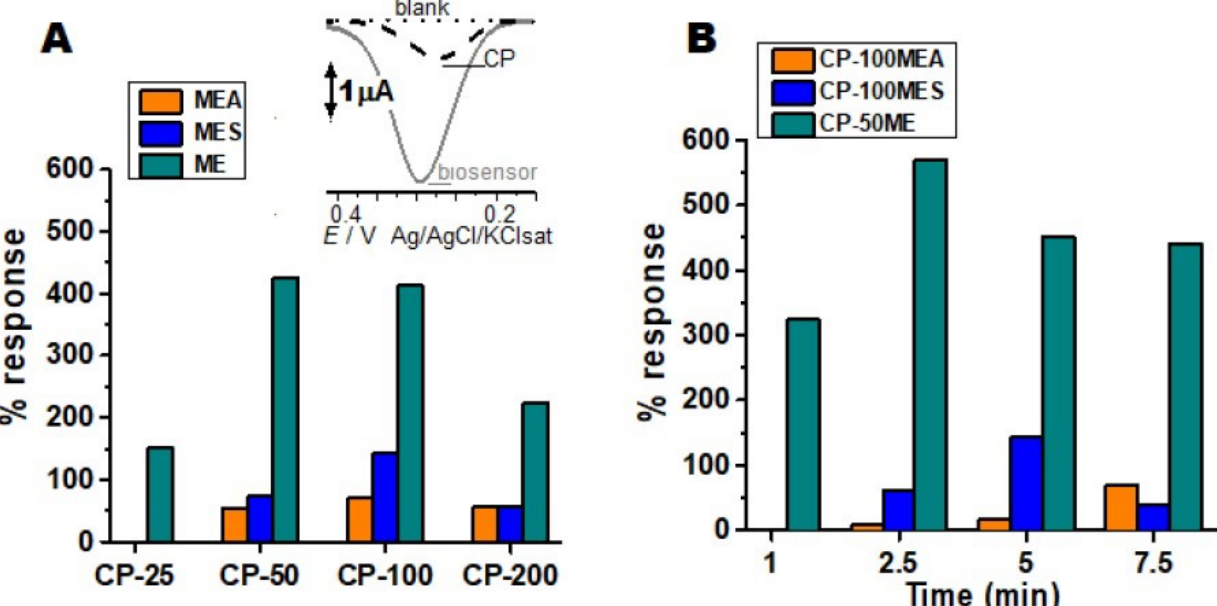
Figure 1. Optimization of biosensors with crude enzymatic extracts. Control: Non modified carbon paste ( A ) enzymatic extracts obtained from solid medium (MEA), minimal liquid medium (ME), and complex liquid medium (MES) in different proportions (25, 50, 100 or 200 µ L in 70 mg of graphite) in the construction of biosensors, tested with the catechol substrate at 10 µ M. Inset: CP-50ME and bare CP in the analysis of the catechol 10 µ M. ( B ) Different enzyme reaction times of the biosensors in the 10 µ M catechol solution, before electrochemical analysis. All tests were performed in 100 mM sodium acetate pH 5.0